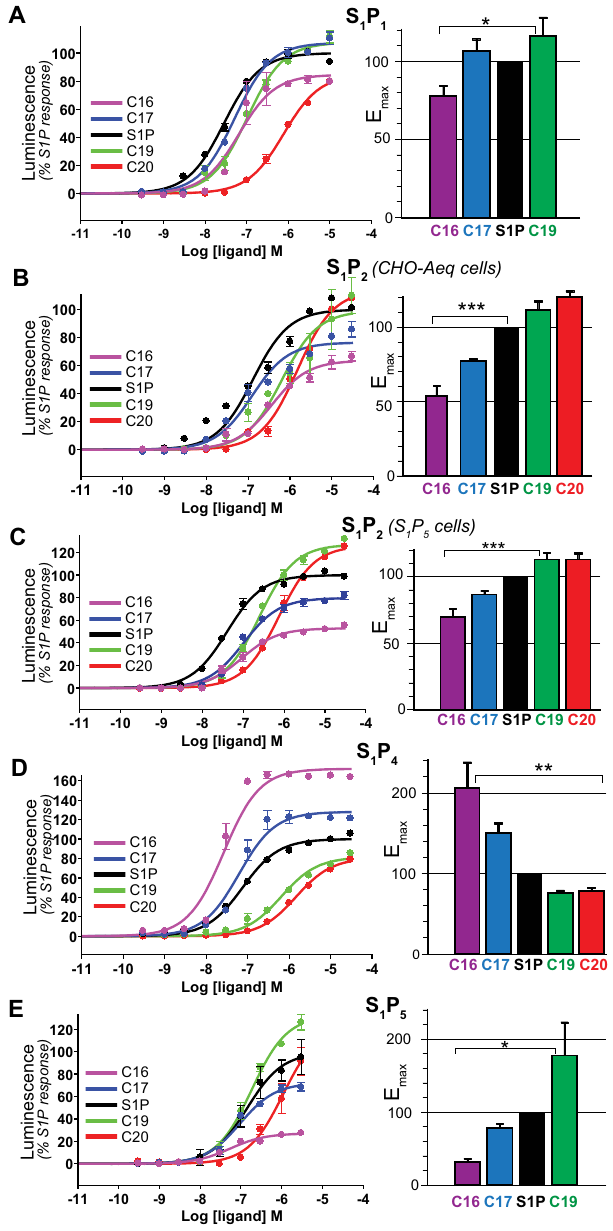
Figure 3. Functional response of S1P receptors to S1P synthetic analogs. Aequoscreen CHO-K1 cells expressing the different S1P receptors were subjected to stimulation with increasing concentrations of S1P- derived ligands and the resulting luminescence was measured. ( A ) S1P 1 , n = 4 ( B ) S1P 2 from CHO-Aeq cells, n = 3 ( C ) S1P 2 from S1P 5 cells, n = 4 ( D ) S1P 4 , n = 4 ( E ) S1P 5 , n = 2. The corresponding dose-response curves for one representative experiment are shown, where each curve represents the mean ± S.E.M of duplicate data points. Luminescence intensities are normalized on maximal response to the natural agonist S1P. Histograms on the right show maximal efficacy (E max ) values calculated for each S1P analog at S1P receptors, based on the sigmoidal fitting of aequorin functional response. The data plotted represent the mean ± S.E.M and are expressed in % of maximal efficacy in response to stimulation by S1P. Statistical significance was assessed using one-way ANOVA with a Scheffe’s post hoc test: * p < 0.05, ** p < 0.01, *** p <